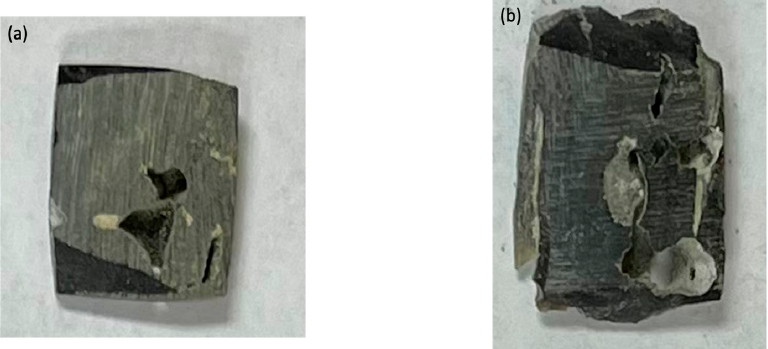
Figure 5. Photographs of ( a ) ALG150 and ( b ) ALG150ITA.